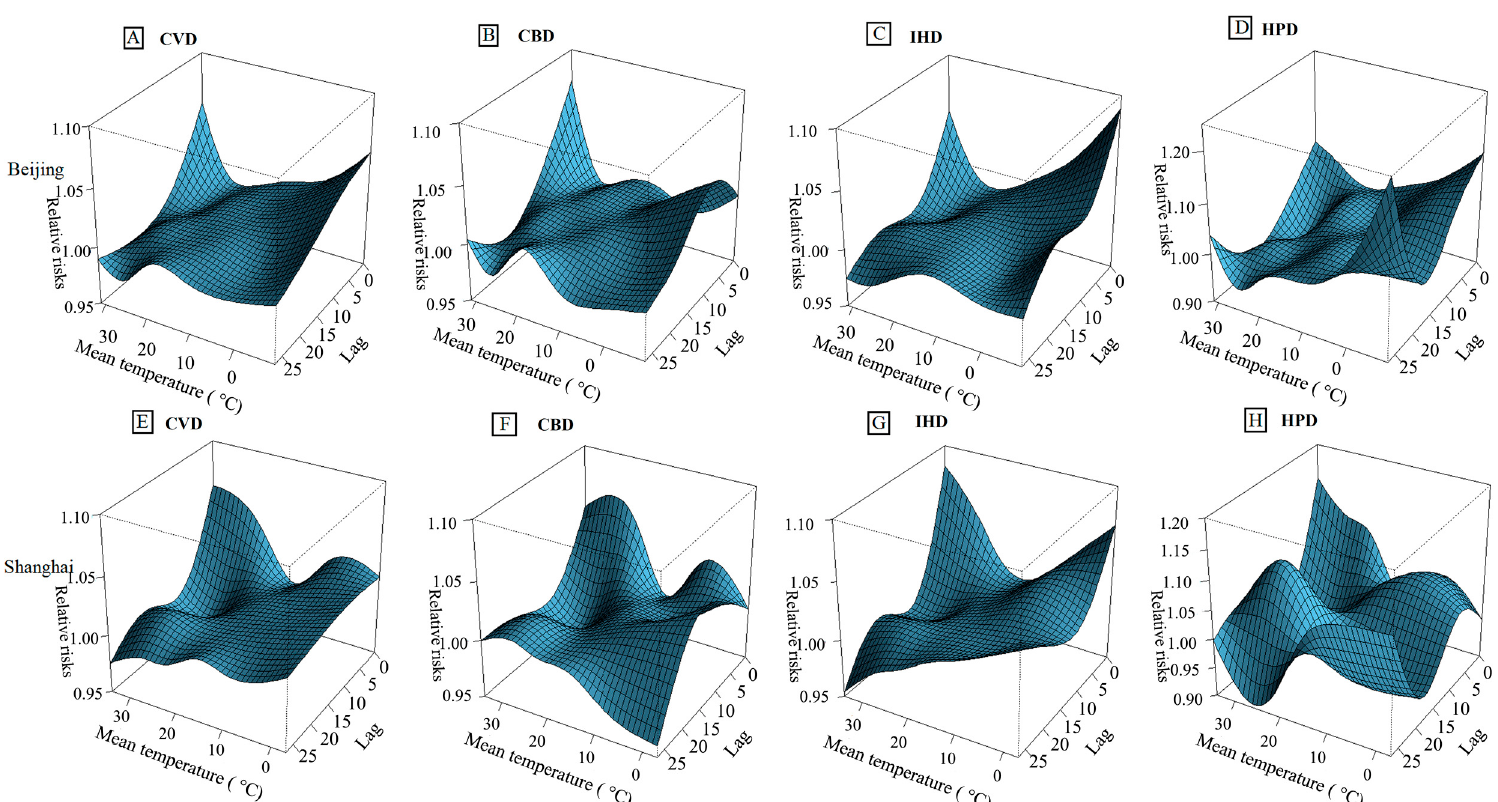
Figure 1. Three-dimensional graph of the relative risks for cause-specific cardiovascular mortality by temperature (°C) and lag days in Beijing and Shanghai, China, during 2007–2009. ( A – D ) The relative risks for mortality of CVD, CBD, IHD and HPD in Beijing, respectively; ( E – H ) The relative risks for mortality of CVD, CBD, IHD and HPD in Shanghai, respectively. The relative risks used five degrees of freedom for temperature and four degrees of freedom for lag up to 27 days. The reference temperatures were 13.6 °C for Beijing and 17.7 °C for Shanghai, respectively.